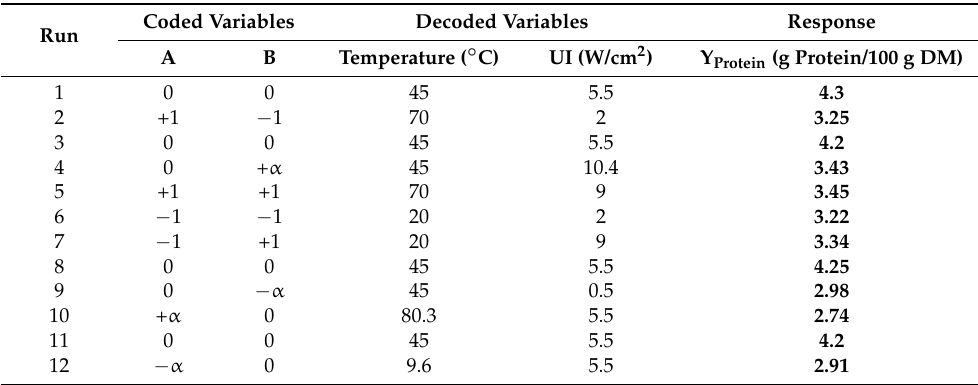
Table 1. Central composite design with their observed response.